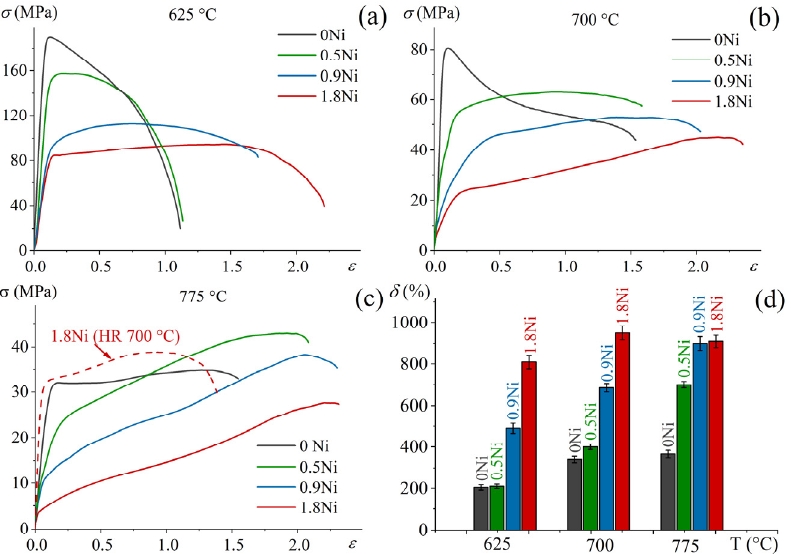
Figure 7. ( a – c ) Stress–strain curves at ( a ) 625 °C, ( b ) 700 °C, and ( c ) 775 °C and ( d ) dependency of elongation to failure ( δ ) at a constant strain rate of 1 × 10 − 3 s − 1 . The microstructural evolution during superplastic deformation has a strong influence on the superplastic behavior. Therefore, the strain-induced evolution of the strain rate sensitivity coefficient ( m) at a nominal constant strain rate of 1 × 10 − 3 s − 1 was investigated. The coefficient m increased from 0.3 to 0.4 with straining to 1.0 and decreased from 0.4 to 0.35 during further straining to 1.2 for the 0Ni alloy (Figure 8). The 0.5Ni and 0.9Ni alloys exhibited high m -values at the initial stage of deformation up to a strain of 1.0; 0.45–0.50 for the alloy with 0.5 wt.% Ni and 0.52–0.62 for the alloy with 0.9 wt.% Ni. A further strain increase led to a decrease in the m coefficient to 0.30–0.40 for the 0.9Ni alloy and to 0.39–0.48 for the 1.8Ni alloy. The 0.9Ni alloy demonstrated m values of about 0.35 throughout the tensile test at a low temperature of 625 ◦ C (Figure